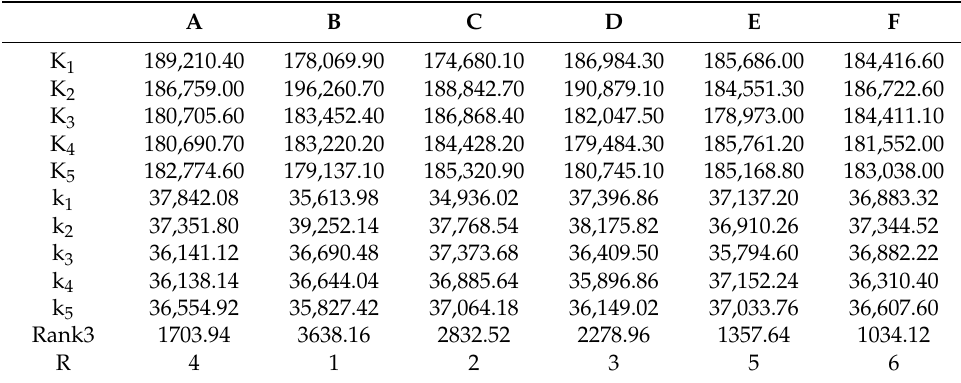
Table 6. Extreme difference analysis for the deform